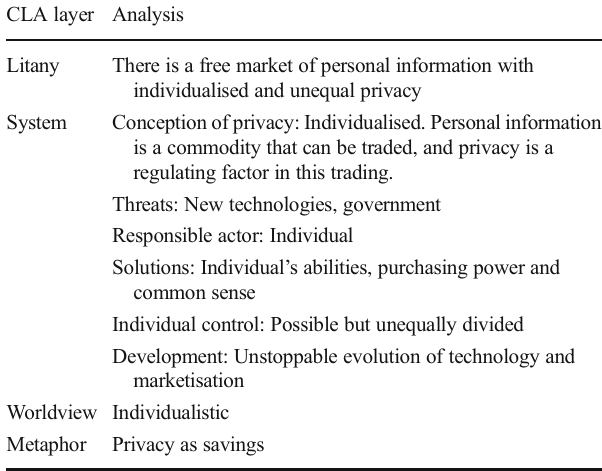
Causal layered analysis of privacy as savings ( n = 4) CLA layer Analysis